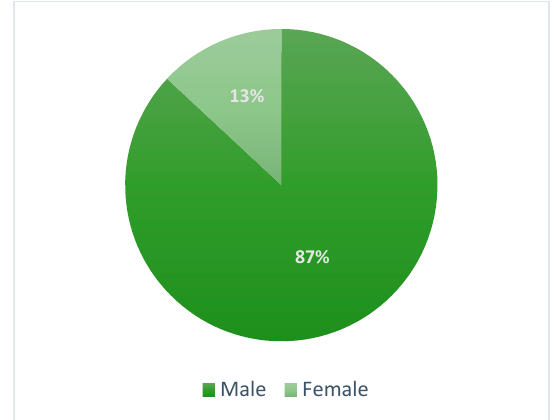
Figure 2. Sex distribution.